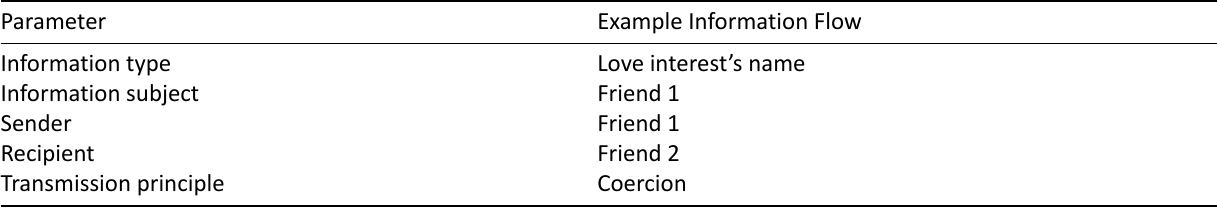
Table 1. Parameters of information